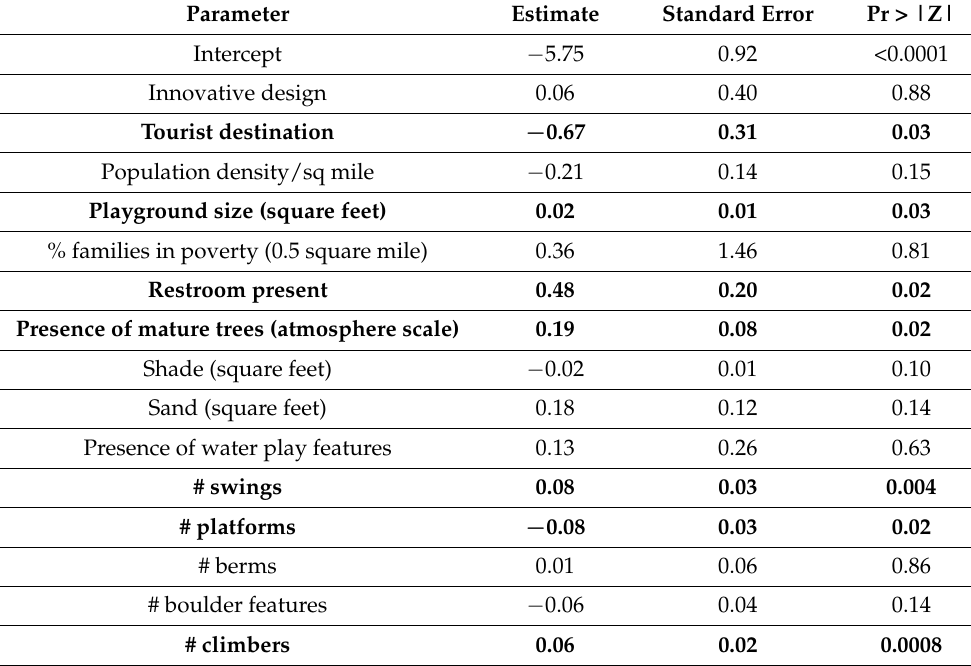
Table 4. Model: factors associated with duration of playground